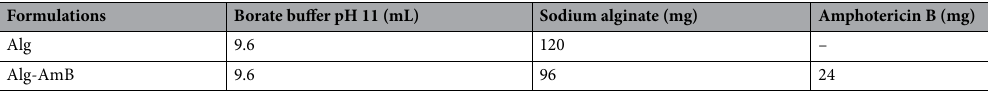
Table 1. Formulation of alginate (Alg) and alginate-amphotericin B (Alg-AmB) to prepare the nanocomplexes.